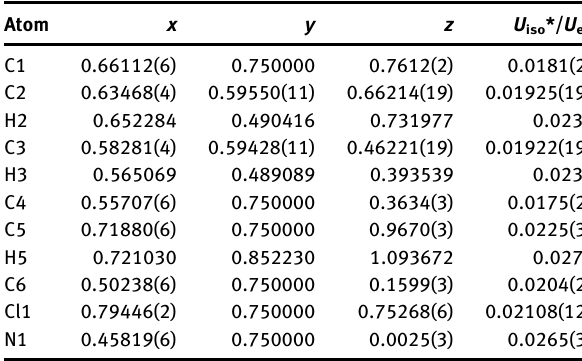
Table  : Fractional atomic coordinates and isotropic or equivalent isotropic displacement parameters (Å 